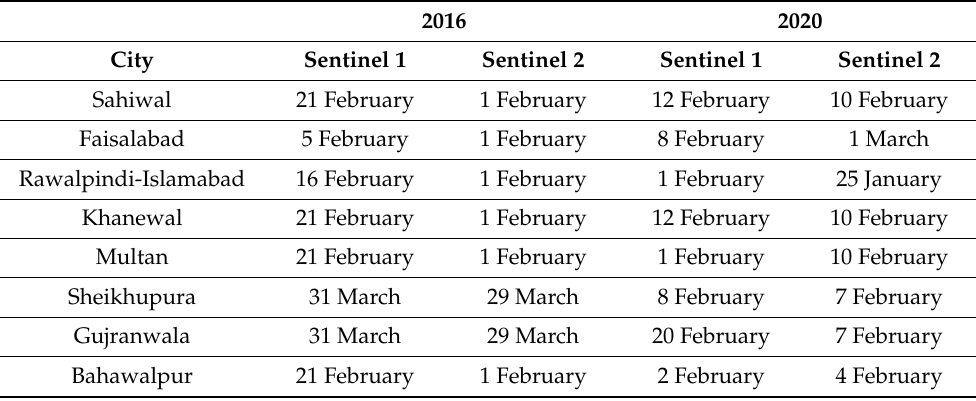
Table 4. Acquisition dates of radar and optical images from 2016 and 2020 for various